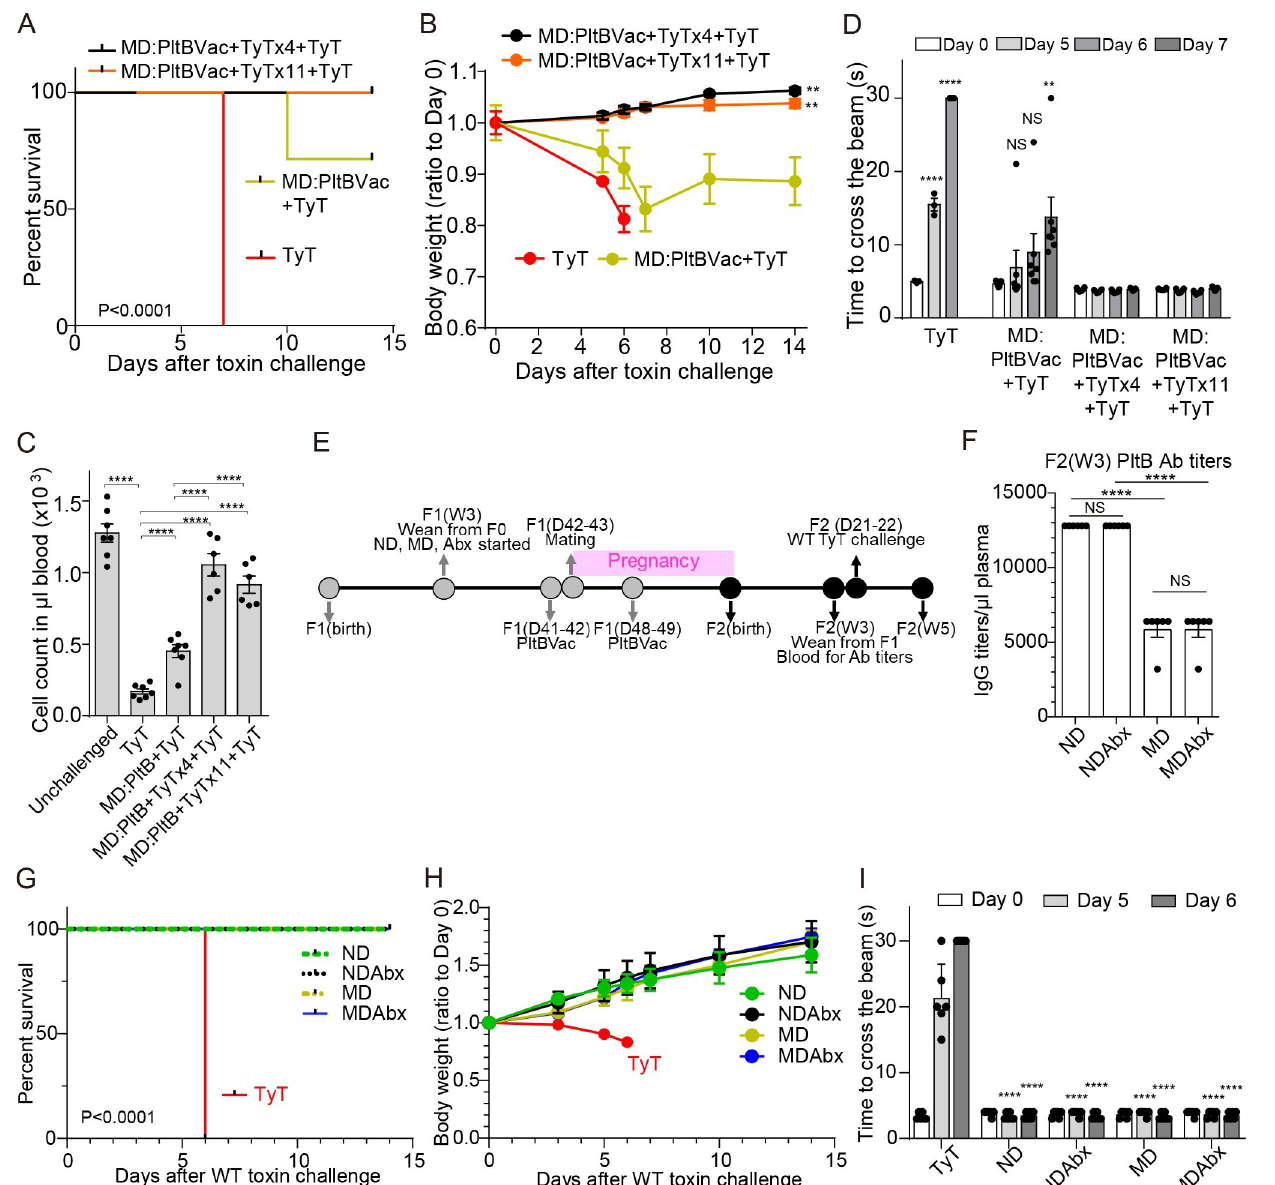
Fig 7. Providing additional toxin-neutralizing antibodies to MD progenies protected all MD F2 mice from a lethal dose of typhoid toxin challenge. A , Survival of the F2 mice received 2 μ g typhoid toxin (TyT). MD:PltBVac (olive), malnourished diet-fed F2 mice maternally vaccinated with PltBVac. MD: PltBVac+TyTx4 (black), malnourished diet-fed F2 mice maternally vaccinated with PltBVac and administered with TyTx4 (monoclonal antibody recognizing the PltB subunits) 30 min before the typhoid toxin challenge. MD:PltBVac+TyTx11 (orange), malnourished diet-fed F2 mice maternally vaccinated with PltBVac and administered with TyTx11 (monoclonal antibody recognizing the CdtB subunit). n = 6–7 F2 mice per group. B , Body weight changes of these F2 mice for the 14 day-experimental period after the typhoid toxin challenge. C , Circulating neutrophil counts in peripheral blood of these F2 mice on day 6 after the typhoid toxin challenge. D , Balance beam walking results of these F2 mice on days 0, 5, 6, and 7 after the typhoid toxin challenge. E-I , Maternal antibody titers available in MD-PltBVac F2 mice at W3 were above the threshold antibody level required for full protection. E , Timelines of indicated diet-feeding, maternal vaccinations, toxin challenge, and assessments for protection. Both F1 and F2 mice were fed with indicated diets, which were started when F1 mice were 3 weeks old and continued throughout the experimental timeframe. F. Maternal antibody titers specific to PltB pentamer available in 1 μ l plasma samples of indicated F2 mice at week 3 (W3). The typhoid toxin challenge was conducted 1-day after harvesting blood samples for antibody measurement. G, Survival of the maternally vaccinated (PltBVac) F2 mice challenged with 2 μ g typhoid toxin (TyT). ND (green dotted), normal diet-fed F2 mice. NDAbx (black dotted), normal diet-fed F2 mice obtained from corresponding antibiotics treated F1. MD (olive dotted), malnourished diet-fed F2 mice. MDAbx (blue solid), malnourished diet-fed F2 mice obtained from corresponding antibiotics treated F1, TyT (red solid), standard regular food-fed F2 mice derived from unvaccinated mothers. H. Relative body weight changes of these F2 mice after receiving 2 μ g typhoid toxin for the 14 day-experimental period. I. Balance beam walking results of these F2 mice on days 0, 5, and 6 after the toxin challenge. Lines and bars represent the mean ± SEM. n = 6 (F2)